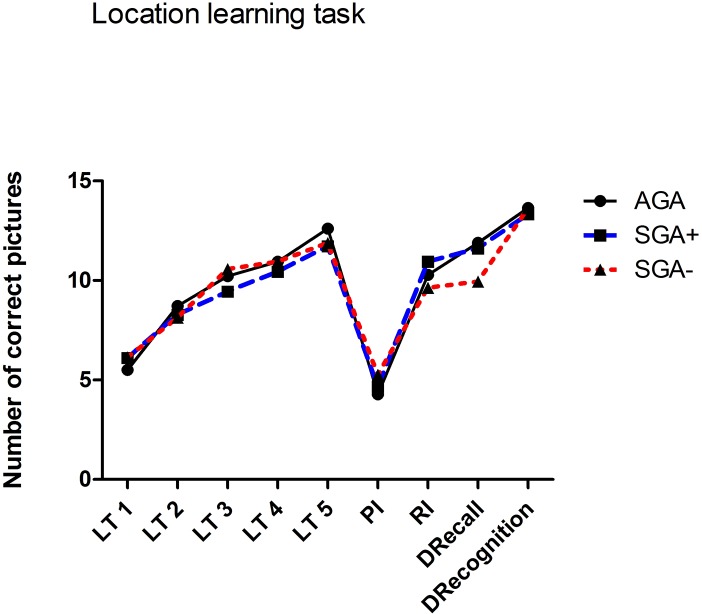
Location learning task.Mean raw scores for group of AGA, SGA+ and SGA- children. LT1 –LT5 = direct recall trail scores, PI = proactive interference score, RI = retroactive interference score, DRecall = delayed recall scores (30 minutes after direct recall trail 5), DRecognition = delayed recognition, AGA = average for gestational age, SGA+ = small for gestational age with catch-up growth, SGA- = small for gestational age without catch-up growth.